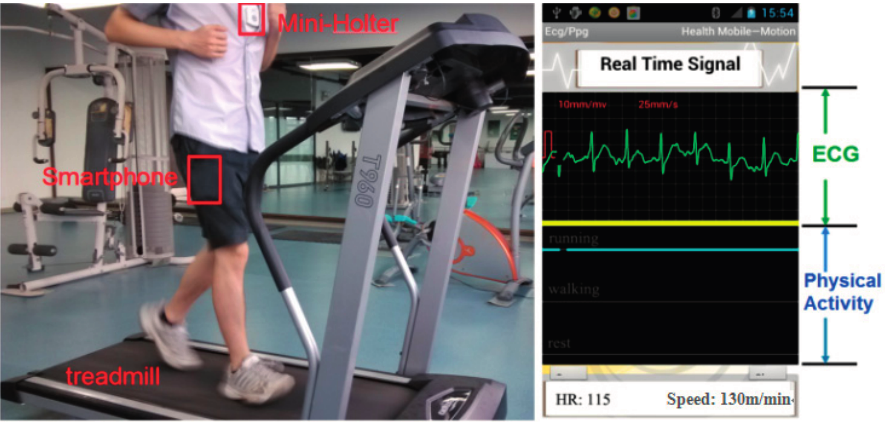
Figure 10. The experiment of ECG Acquisition system with physical activity recognition on a